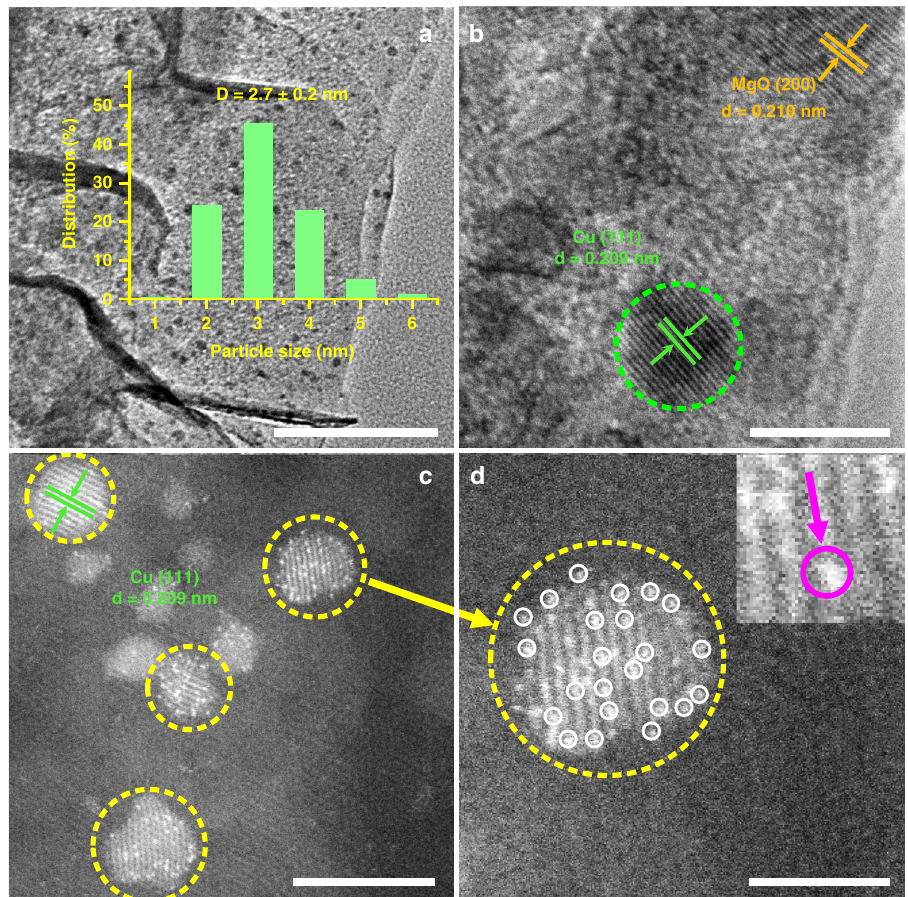
Fig. 2 Identi fi cation of PtCu single atom alloy. a TEM image, b HRTEM image, c AC – HAADF – STEM image of PtCu – SAA, and d corresponding enlarged images. Scale bars: a 100 nm; b 5 nm; c , and d 2 nm.